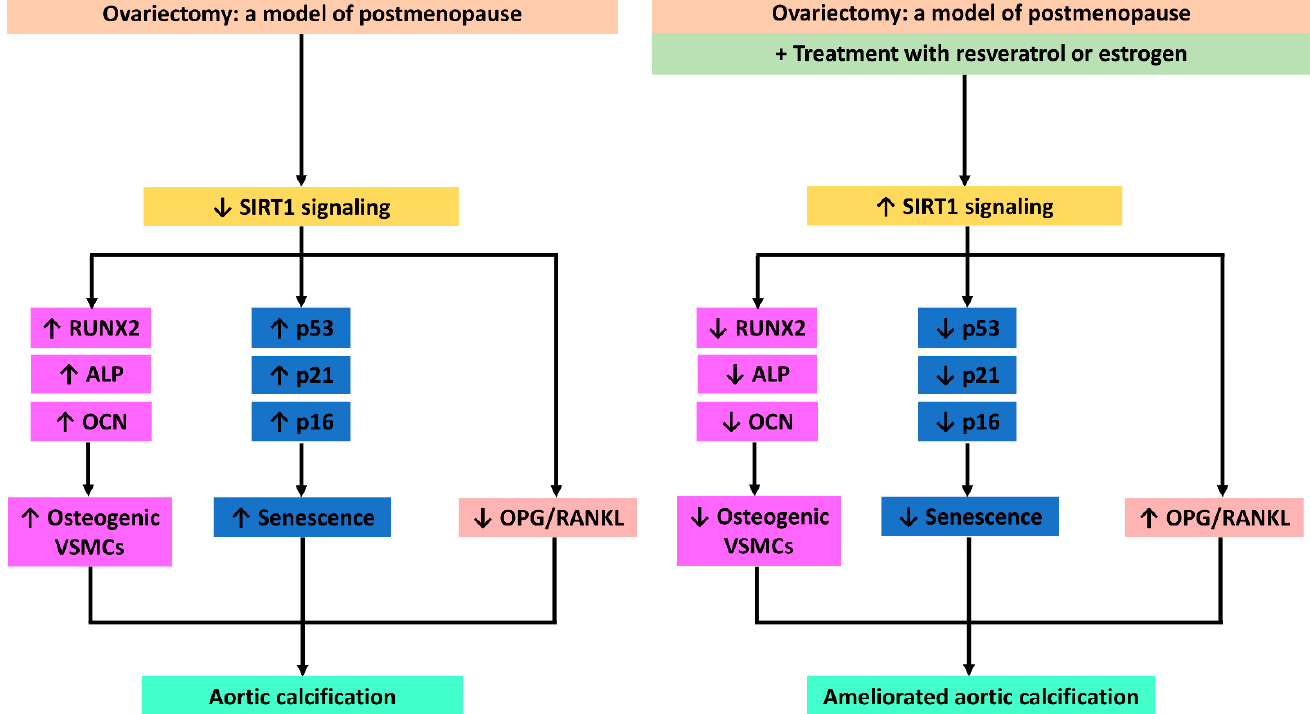
Figure 7. Resveratrol and estradiol ameliorated aortic calcification in ovariectomized rats via SIRT1 signaling.